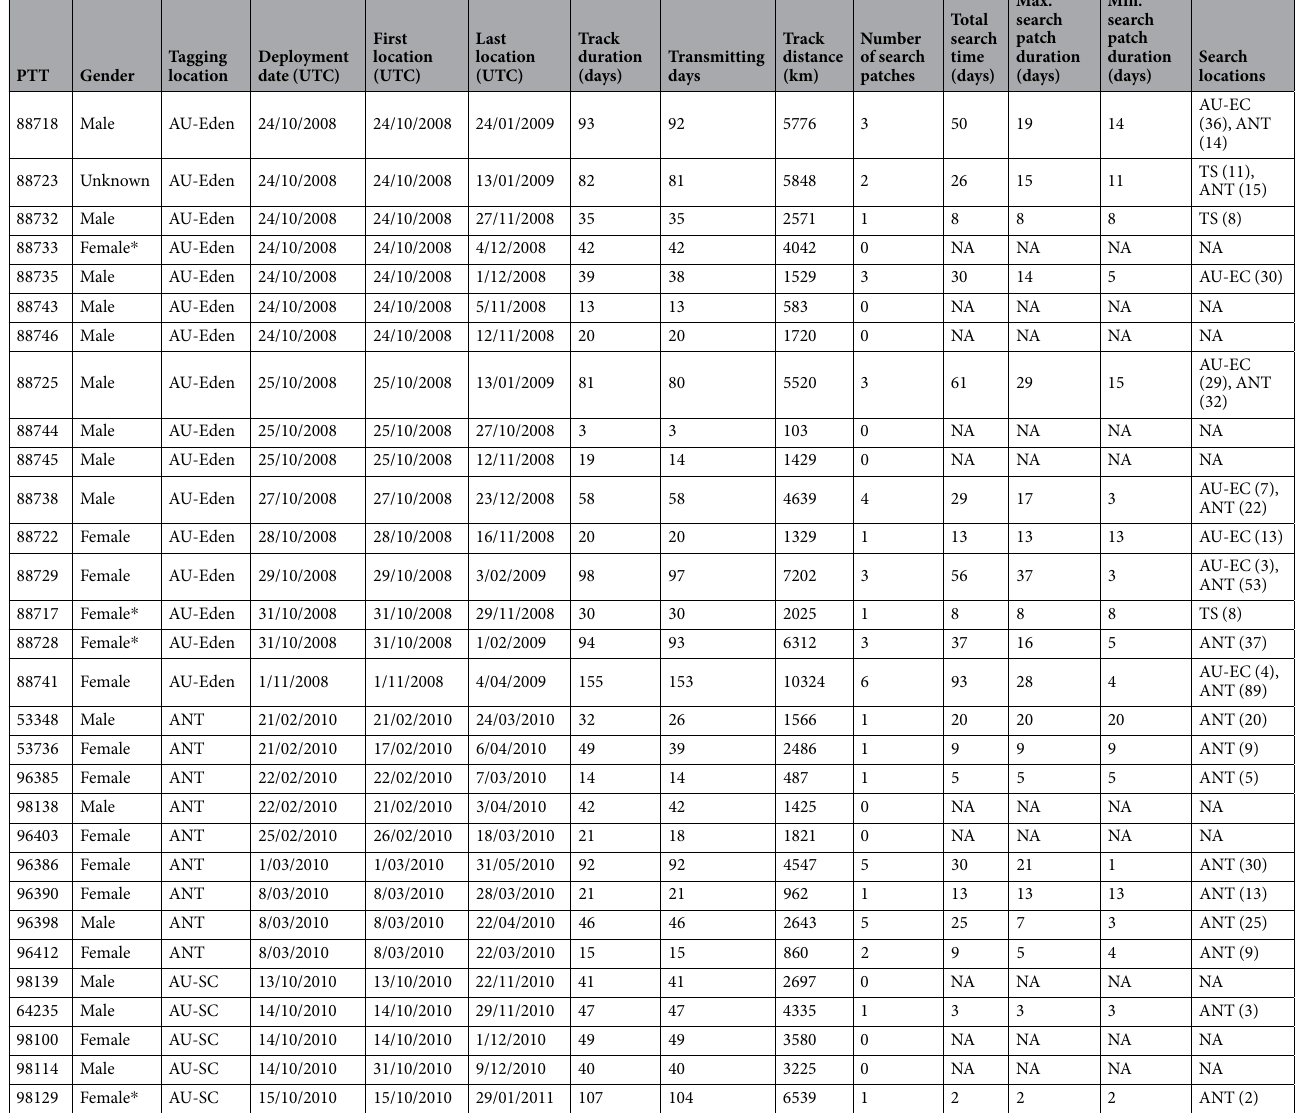
Table 1. Summary of satellite tags deployments and the resulting tracking information. For tagging location: AU-Eden is Eden, Australia; ANT is Antarctica; AU-SC is Sunshine Coast, Australia. For search location: AU-EC is east coast Australia, ANT is Antarctica, TS is Tasman Sea and number of days searching in each location is given in parentheses. * Indicates where gender was inferred by behaviour (with calf) at time of tagging (determined via biopsy otherwise).